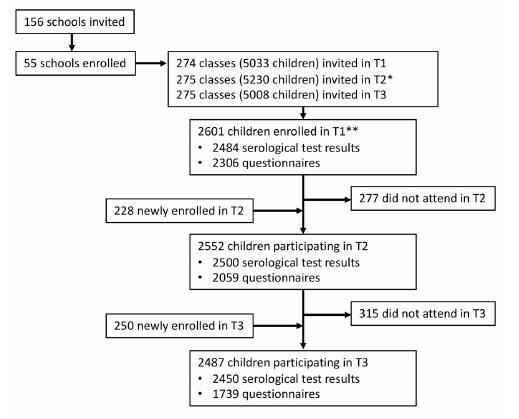
Figure 1: Flowchart of study participants. T1 – testing in June-July 2020, T2 – testing in October-November 2020, T3 – testing in March-April 2021. Newly enrolled children were not tested in the previous round; did not attend means they did not attend the sub- sequent round. * Some classes were split or rearranged after the summer break. ** 16 of these children were enrolled from late Au- gust to early September 2020 (10 serological results, 16 question- naires